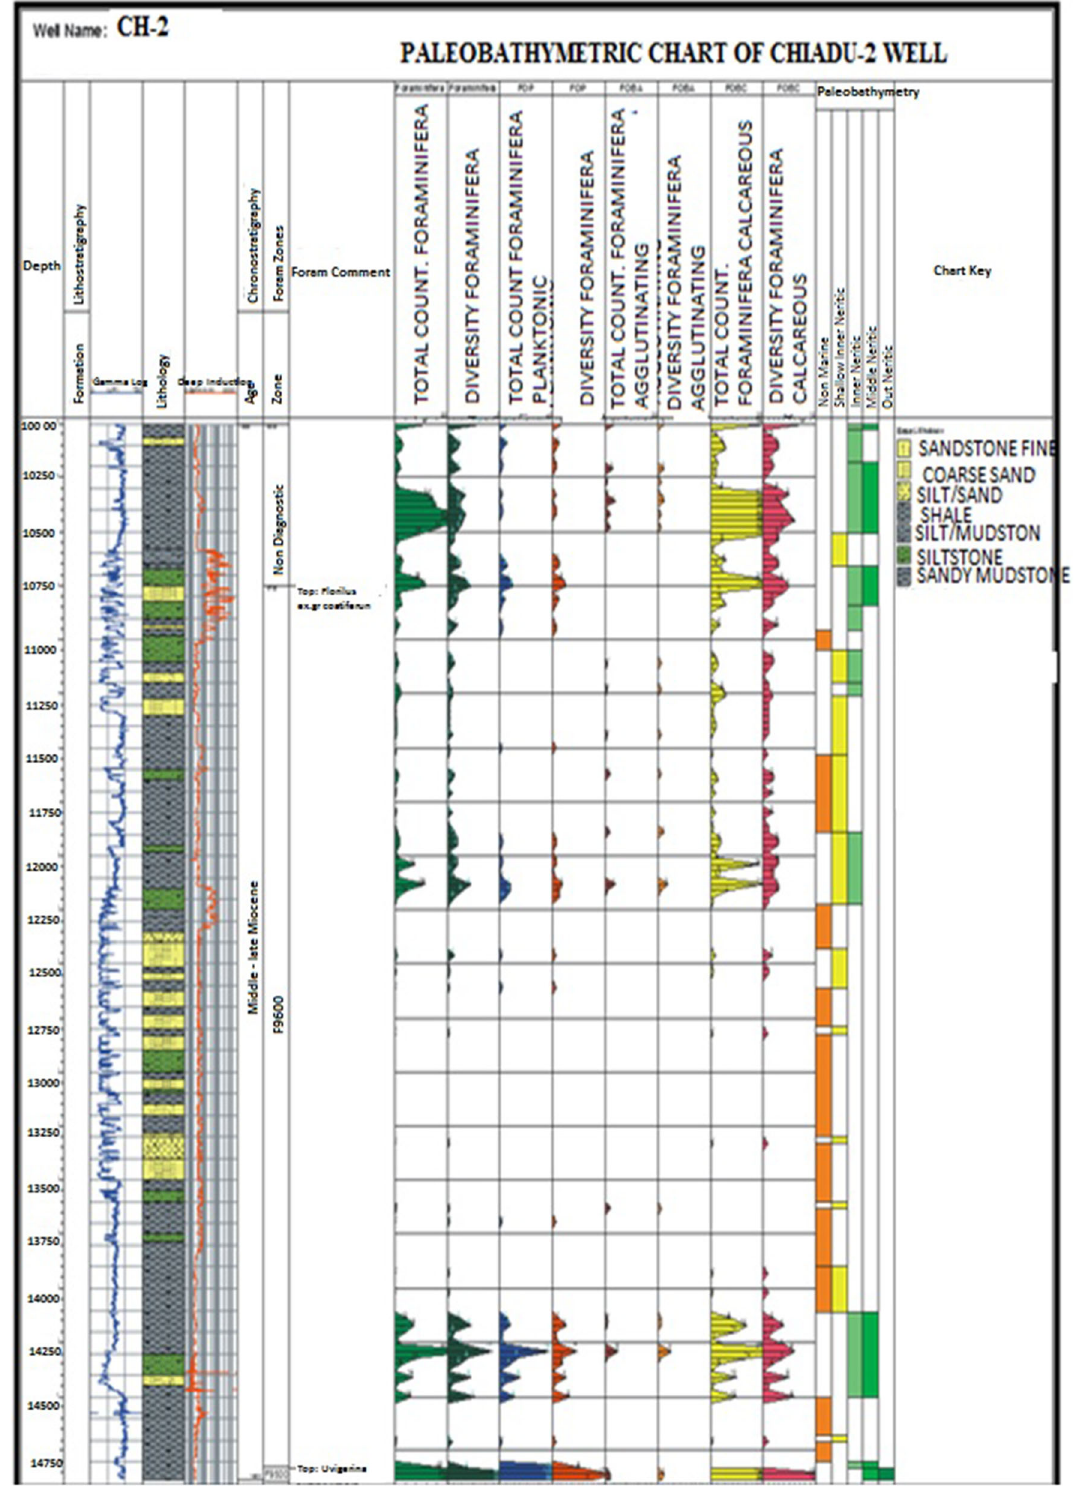
Fig. 2 Biostratigraphic chart of well